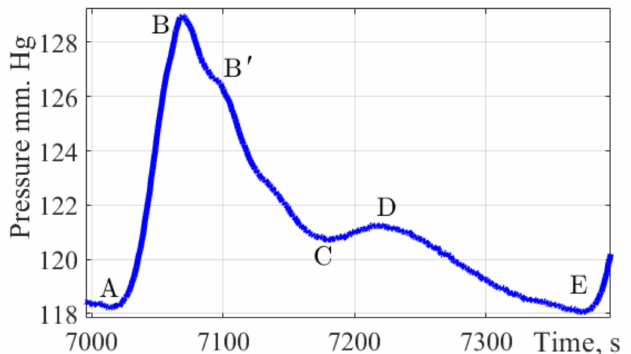
Figure 2. The pulse wave signal fragment. The figure shows a fragment of a single pulse wave contour obtained by the authors of the study, with characteristic points of dynamic changes in pulse pressure applied A, B, B (cid:48) , C, D,